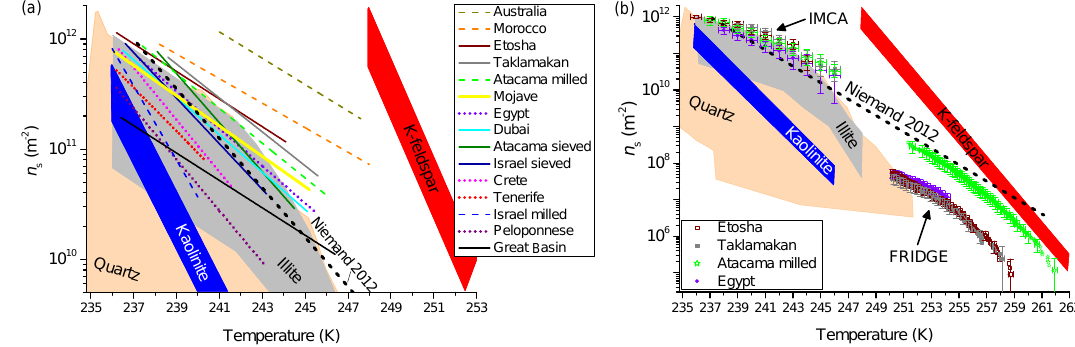
Figure 5. (a) Ice-active surface site density fits for all dust samples. The fit parameters are given in Table 4. Solid lines indicate surface- collected and sieved samples, dashed lines surface-collected, and milled samples and dotted lines are airborne samples. (b) Full temperature range measurements are taken by IMCA and FRIDGE. Colors and markers are the same as in Fig. 4. IMCA data are binned into 1K-intervals. Error bars are drawn for every 10th data point. A parameterization for desert dust from Niemand et al. (2012) is shown as a thick dashed line. Parameterizations for kaolinite (Murray et al., 2011), illite (Broadley et al., 2012), and K-feldspar (Atkinson et al., 2013) as well as the range of data for quartz (Atkinson et al., 2013; Zolles et al., 2015) are given as areas representing the range between n s,BET , as provided in the literature, and the corresponding n s,geo . See text for details on the calculations of n s,geo